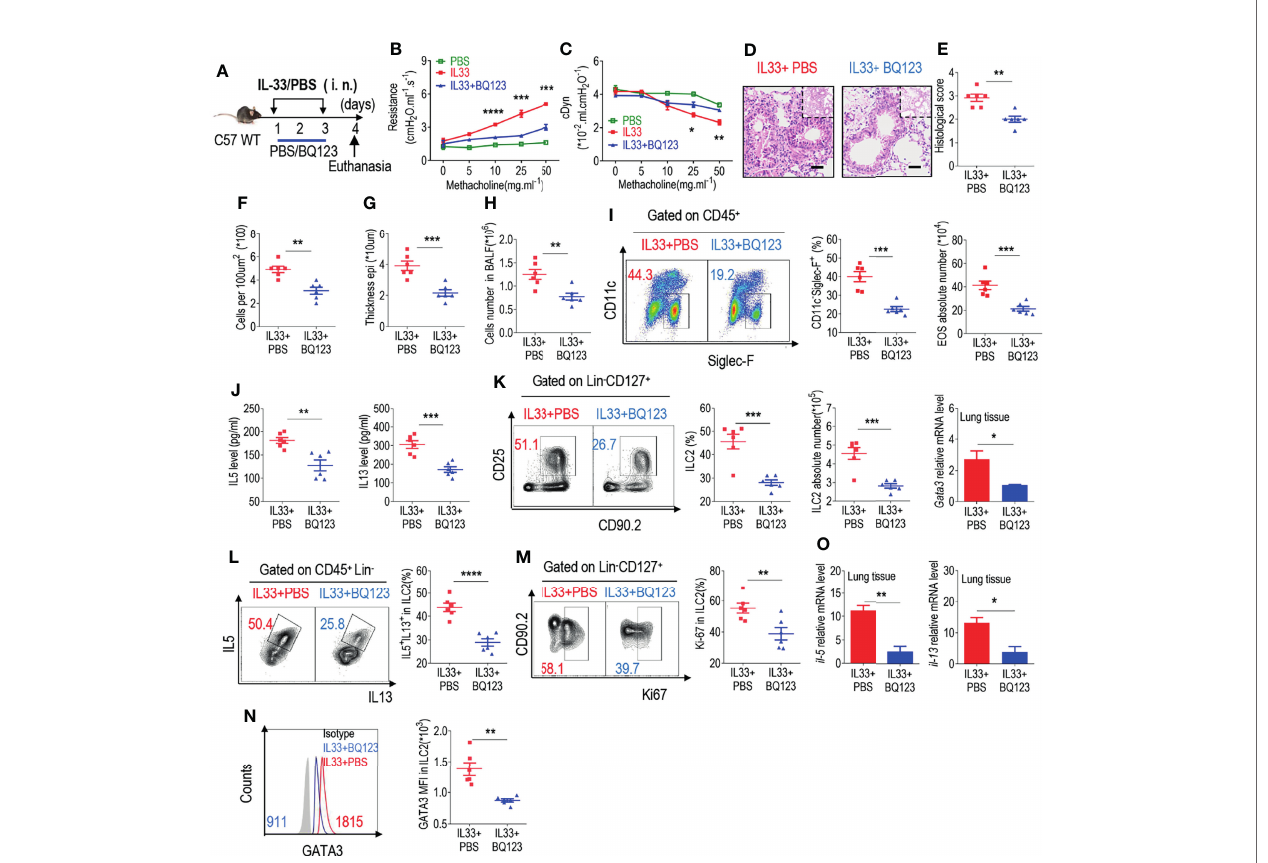
FIGURE 2 | BQ123 inhibited the functional activation of ILC2s in response to IL-33 challenge. (A) Experimental scheme. Female C57BL/6J mice were intranasally challenged with IL-33 on days 1 – 3 and were sacri fi ced 24 h after the last challenge on day 4. (B, C) Line graphs show lung resistance and dynamic compliance (cDyn) in response to increasing doses of methacholine. (D – G) Representative hematoxylin and eosin (H&E) staining of lung sections (D) and in fl ammation scores ( E ), as well as the in fi ltrating cells (F) and airway epithelium thickness (G) were presented. Bars, 100 m m. Absolute number of BALF (H) , both fl ow cytometry and statistical results of population, and the absolute number of EOS in the BALF (I) were shown. (J) Amounts of IL-5 and IL-13 in the BALF. (K – N) Representative results of both fl ow cytometry and statistical analysis of the frequencies of ILC2s, and absolute counts (K) , IL-5 + IL-13 + ILC2s (L) , Ki67 + ILC2s (M) , and levels of GATA3 protein (N) in the lungs were indicated. (O) The mRNA expression levels of ILC2-related target genes in lung tissues, including Il5, Il13 , and Gata3 , were evaluated; b -actin level was used for normalization, and the lowest expression level in the IL33 + BQ123 group was arti fi cially set to 1 (n = 3). Data are representative of two or three independent experiments (n = 6 for the IL33 + phosphate-buffered saline (PBS) group; n = 6 for the IL33 + BQ123 group). Note: *P < 0.05; **P < 0.01; ***P < 0.001; ****P < 0.0001. In all panels, individual results and mean ± standard error of the mean (SEM) are shown; statistical signi fi cance was determined using a two-tailed unpaired Student ’ s t-test (B, C, E – M, O) or Mann-Whitney test (N)